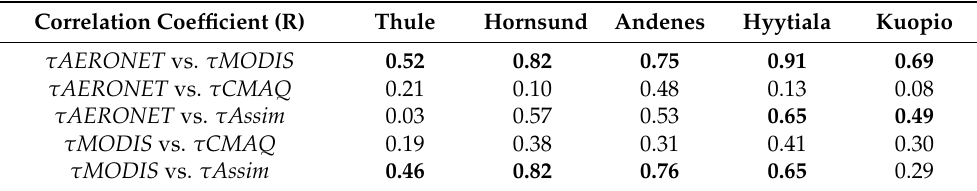
Table 2. Correlation coefficients among AODs from AERONET, MODIS, model, and data assimilation at several AERONET stations. Correlation Coefficient (R) Thule Hornsund